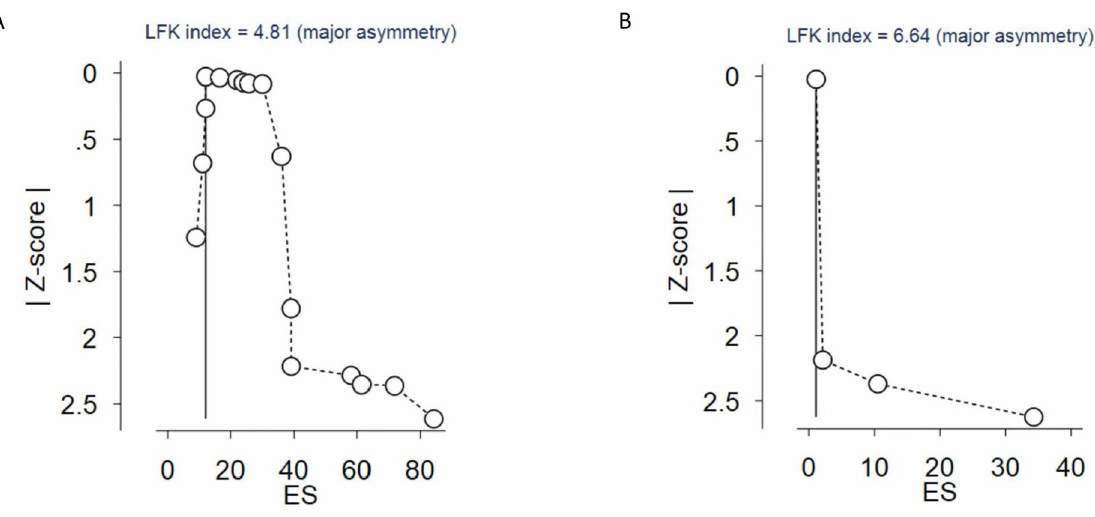
Fig 6. Doi Plots for Animal Models (A) and IPSCs